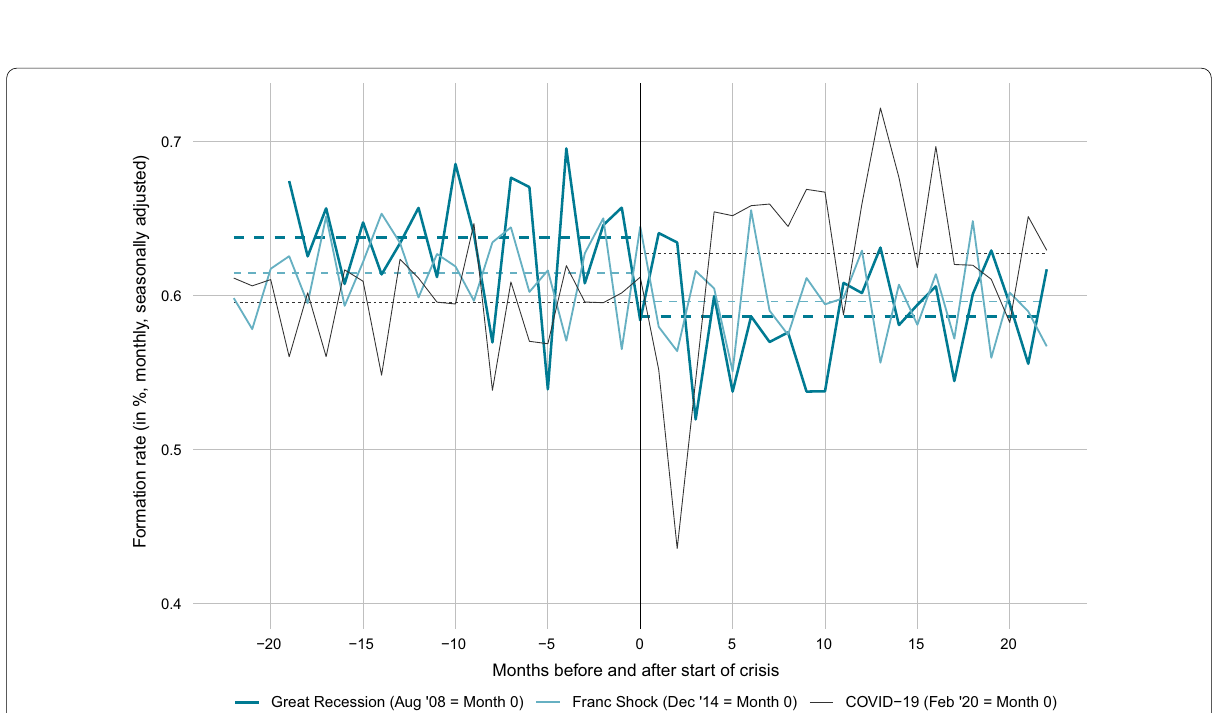
Fig. 13 Comparison of start-up activity before and after crisis periods. Notes : The figure shows the monthly start-up rate ( adjusted frequency of total firm start-ups divided by the total stock of firms) in Switzerland before and after the start of the Great Recession, the Swiss Franc Shock and the COVID-19 crisis. Month 0 is the last month before the crisis start. The dotted lines are the average bankruptcy rates over the 22 months before or after the respective crisis